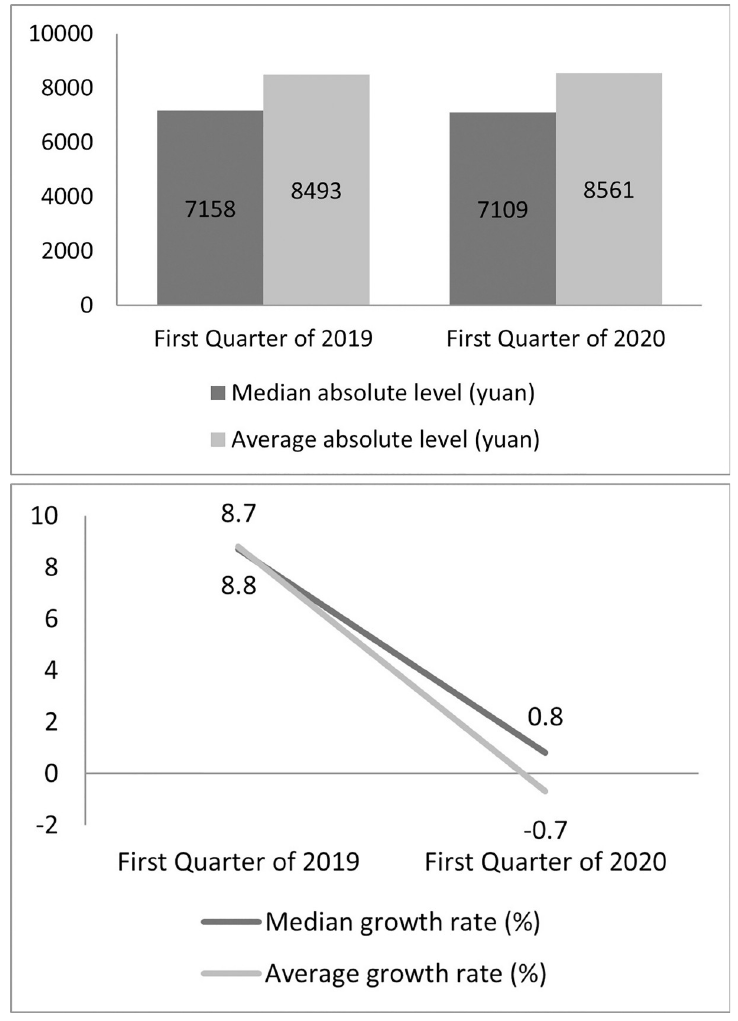
Fig 1. Quarterly changes in household income. ( A ) Median & Absolute Level of income; ( B ) Median and average growth rate of income. (Source 2 NBS China [4]). As various sectors of the economy are hit hard by COVID-19 but the poor and vulnerable communities are affected the most. Poor households and people living under poverty are con- sidered to suffer due to the lockdown and closures of markets and business operations. Most of these people work on daily wages and may be unemployed with no alternate source of income. Governments across the world have stepped up relief and provision of subsidies to their citizens still the challenge for these vulnerable communities to recover hang in the air even after the pandemic is over [5]. In terms of developing countries, people living in low- income households face dual misfortunes: income-generating difficulties and vulnerability to socio-economics crises [6]. Poor households and people who are unprepared to cope with such shocks seem to be hit hardest by recession, inflation, disease and civil unrest. Similar trends are observed in terms of the impacts of COVID-19 on communities of different income groups. On contrary, rich households have greater access and a broader asset base to insurance and credit services, which will help cushion them against the effects of an external shock [7].